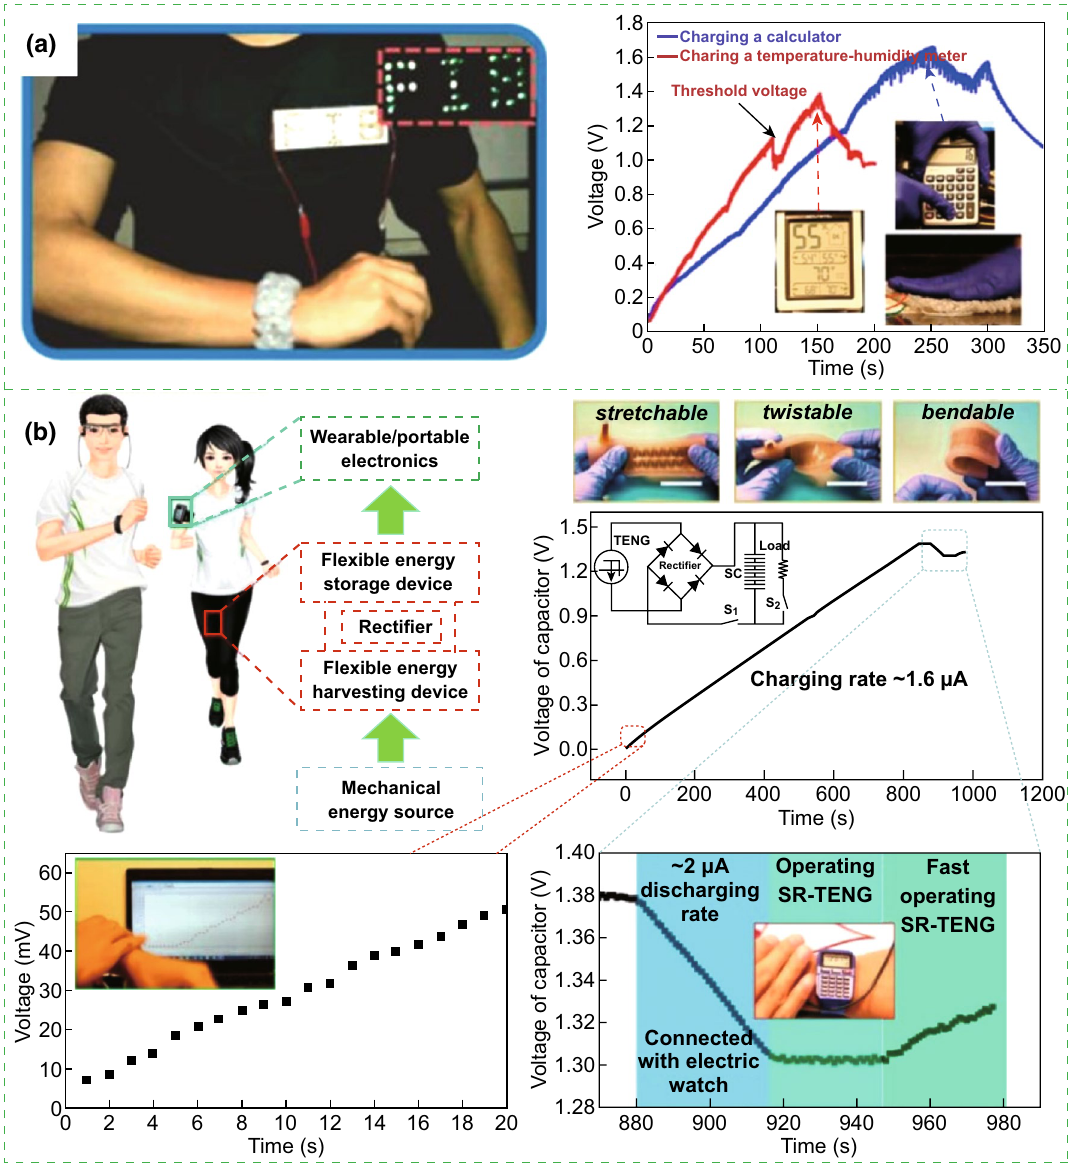
Fig. 14 a LED warning sign on a shirt, that is, “FIB,” is lighted up by tapping a TENG bracelet wrapped on the wrist. Charging curves of two‑ series SCs by manually tapping the TENG fabric. The inset pictures are the temperature–humidity meter (left), calculator (upper right), and hand tapping fabric (lower right). Reprinted with permission from Ref. [22]. b Application of the all‑in‑one shape‑adaptive self‑charging power pack‑ age in conventional wearable electronics. Reprinted with permission from Ref.